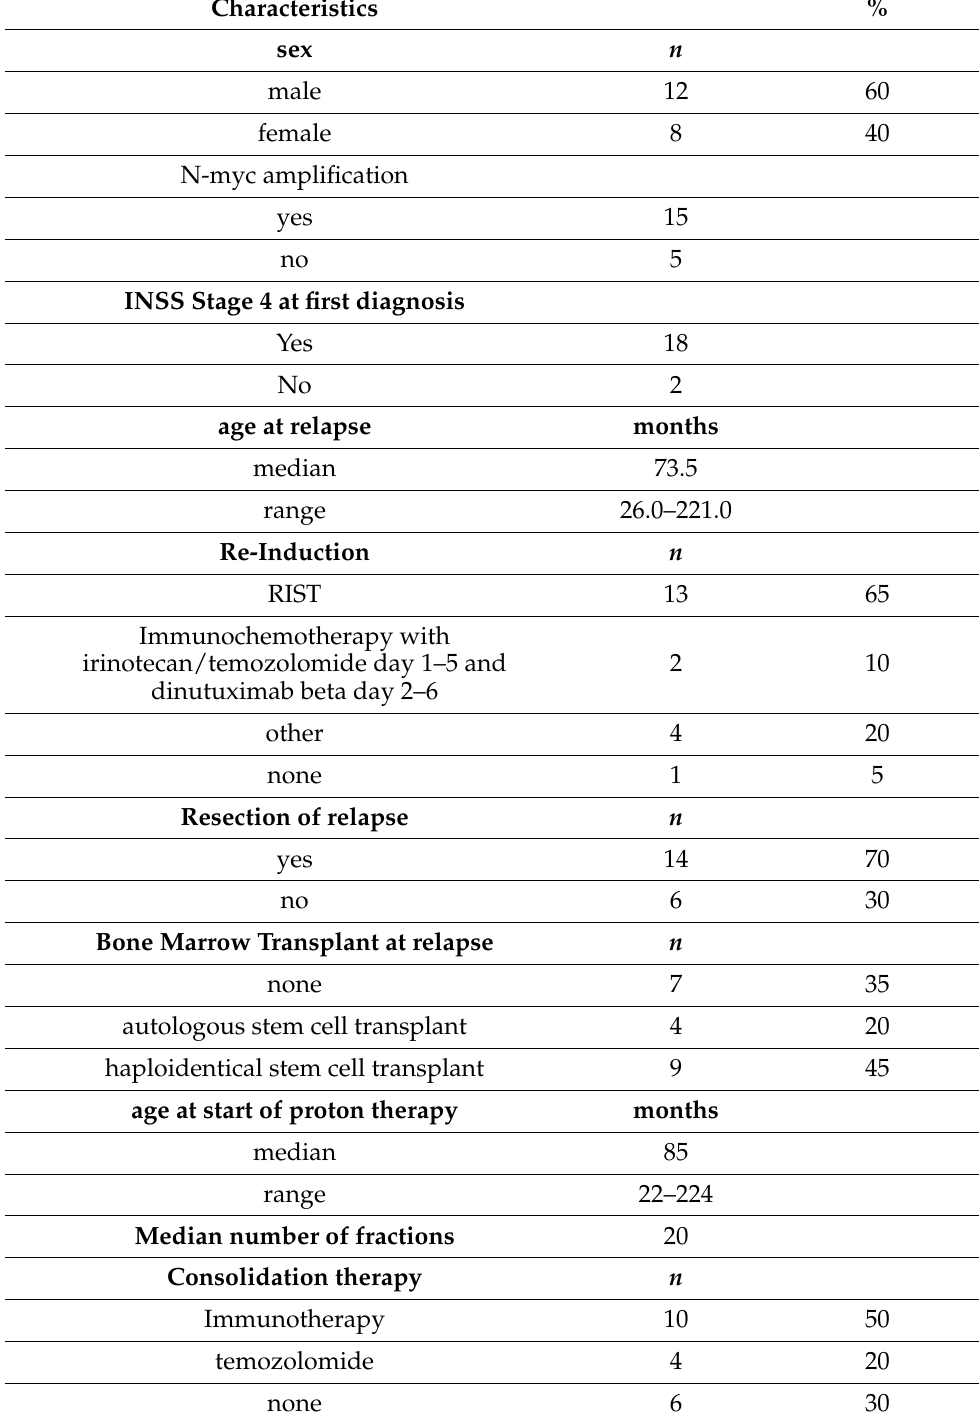
Table 1. Patient and treatment